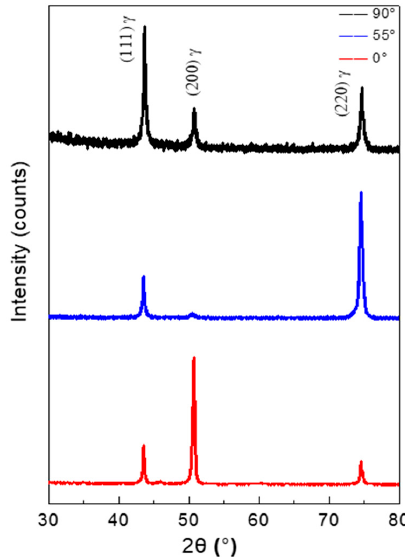
Figure 3. X-ray diffraction (XRD) patterns for the 0 ° , 55 ° and 90 ° specimens of the EBM-In718 alloys.